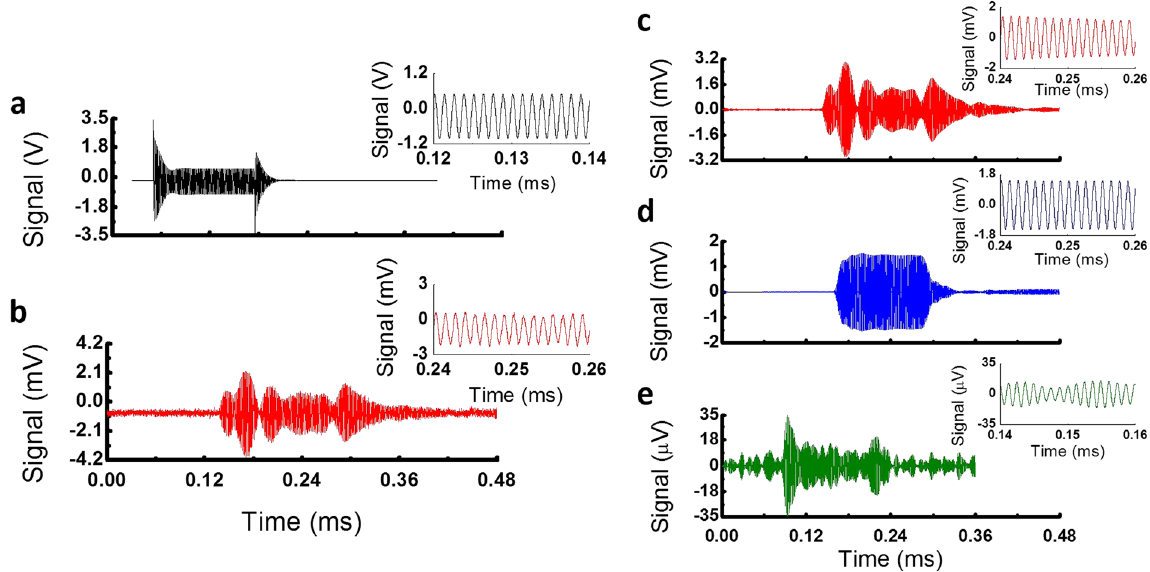
Figure 5. Temporal response of different ultrasound detectors to an 800 kHz air-coupled ultrasound transducer (Japan Probe 0.9K14x20N-RX). Transmit ultrasound burst of 100 cycles was generated. All data were averaged 512 times. Response data in ( c , d and e ) are post-filtered with a bandpass filter with f 0 = 800 kHz and Δ f = 200 kHz. Inset shows sinusoidal temporal signals for each detector. ( a ) Driving voltage input to the 800 kHz ultrasound transmitting transducer. Sinusoidal burst output with center frequency of 800 kHz was sent to the transmitter. ( b ) Detected transmission signal from the ring resonator. ( c ) Post-filtered response of ring resonator. ( d ) Post-filtered signal from the 800 kHz receiver. ( e ) Post-filtered signal from the